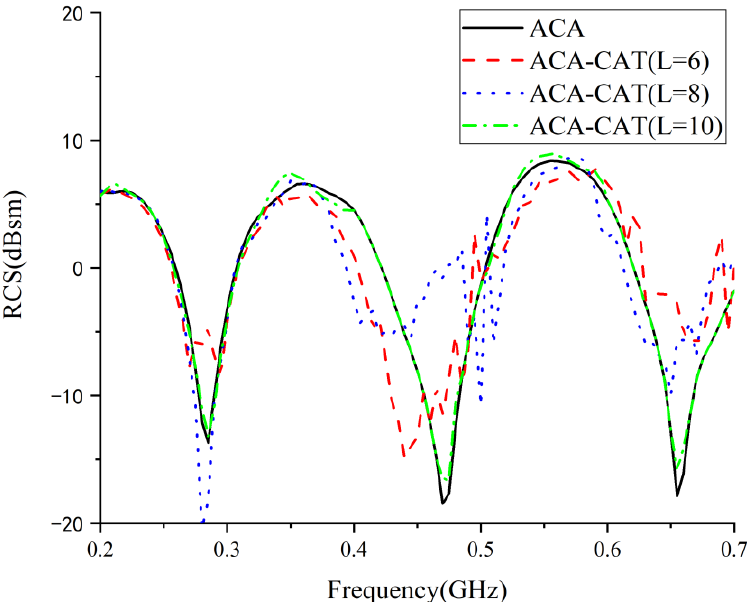
Figure 13. Broadband BCS of the dual missile is computed by ACA-CAT for three different orders.